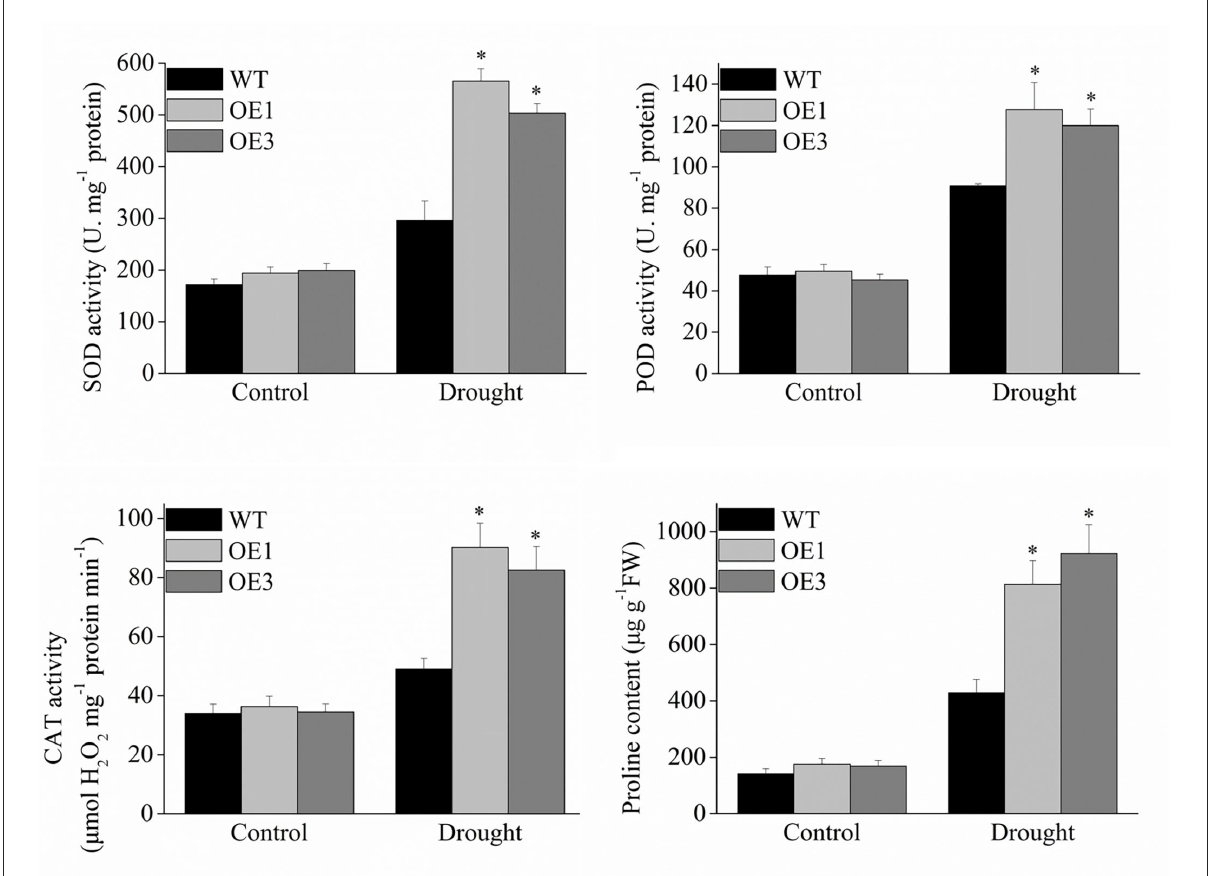
FIGURE8 The total activities of the antioxidant enzymes and proline content in transgenic and wild-type plants under drought stress. Four-week-old tobacco plants were treated with drought stress for 10 days, and the activities of SOD, POD, CAT, and proline content were measured. Bars represent mean ± SD. A significant difference from the WT was confirmed by a one-way ANOVA test, * p < 0.05.